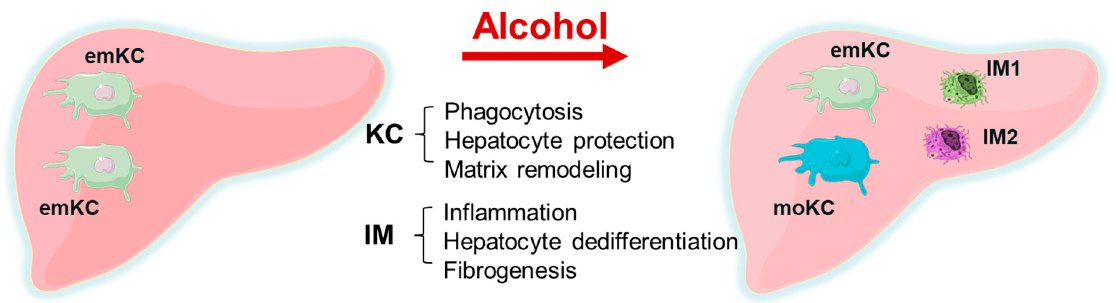
Figure 1. Liver macrophage population changes induced by alcohol. In response to alcohol, there is an influx of monocyte-derived infiltrating macrophages (IM) as well as loss of embryonic Kupffer cells (emKC), with their replacement by monocyte-derived Kupffer cells (moKC).